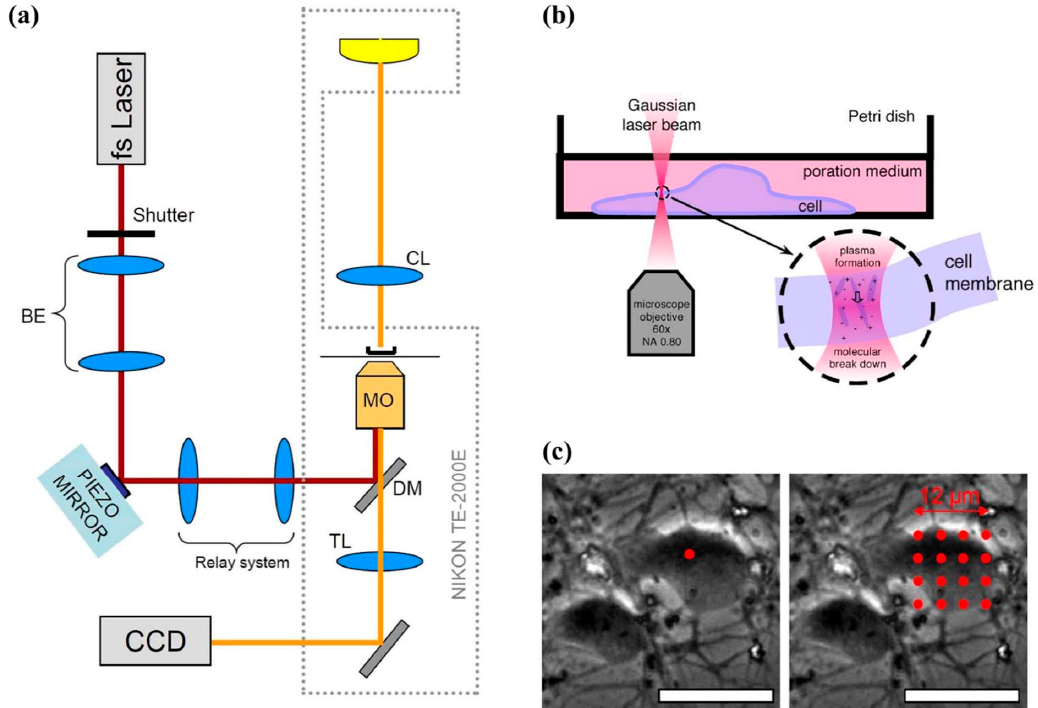
Figure 16. Optical transfection system using femtosecond laser ( a ) Schematic of the optical transfection system. ( b ) Side view of the Petri dish containing a single-neuron for transfection. ( c ) Irradiation patterns (red dots) superimposed on phase-contrast images of cortical neurons. Reprinted with permission from [175].